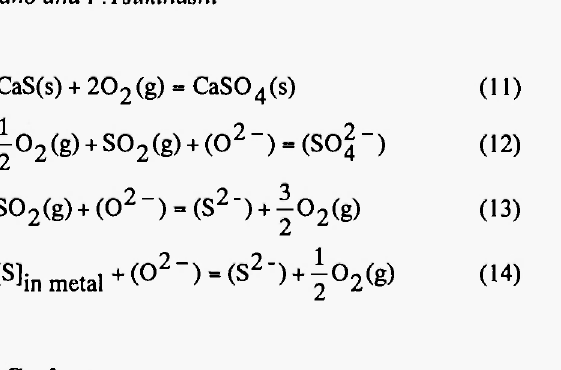
0.8 .0 Optical Basicity Fig. 11: Relationship between the Cu 2+ /Cu + ratio and